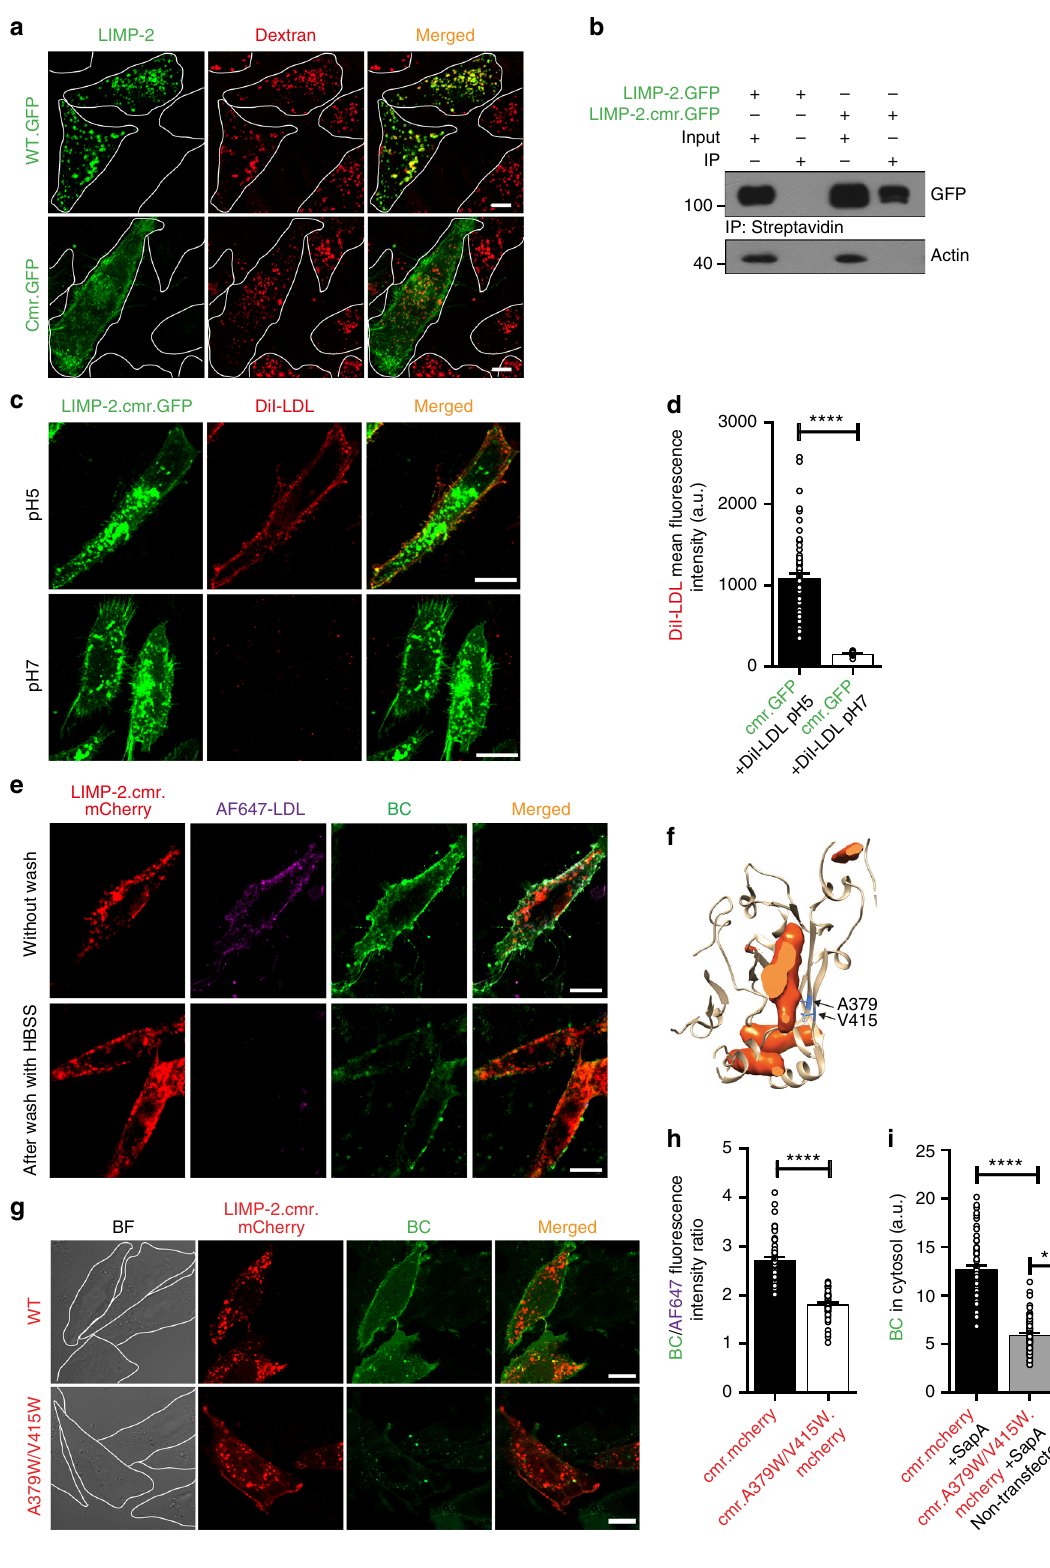
knockout compared to wildtype MEFs (Fig. 3e), in agreement with the imaging results (Fig. 3b, c). Similar results were obtained when cells were radiolabeled with [ 3 H]oleic acid:BSA complex with or without simultaneous addition of LDL, followed by determination of the incorporation of [ 3 H]oleate into CE